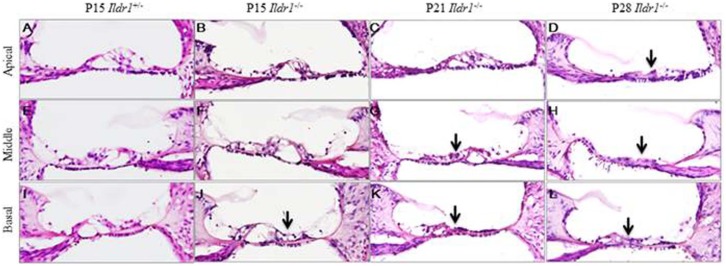
Hematoxylin and eosin labeling of frozen cochlear sections showing the structure of the organ of Corti.The organ of Corti from the apical (A–D), middle (E–H), and basal turns (I–L) of the cochlea are shown separately. Black arrows in J show the disruption of the organ of Corti in the basal turn of P15 Ildr1−/− mice. Black arrows in G,K show the progressive disruption of the organ of Corti in the basal and middle turns of P21 Ildr1−/− mice. Black arrows in D,H,L show the complete disruption of the organ of Corti in all turns of the cochleae of P28 Ildr1−/− mice.